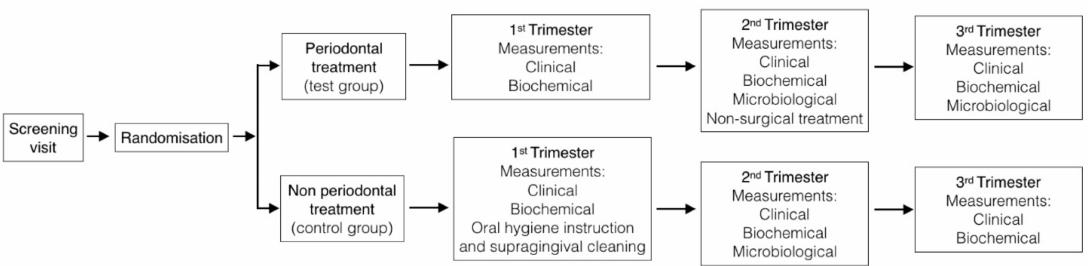
Figure 1. Research